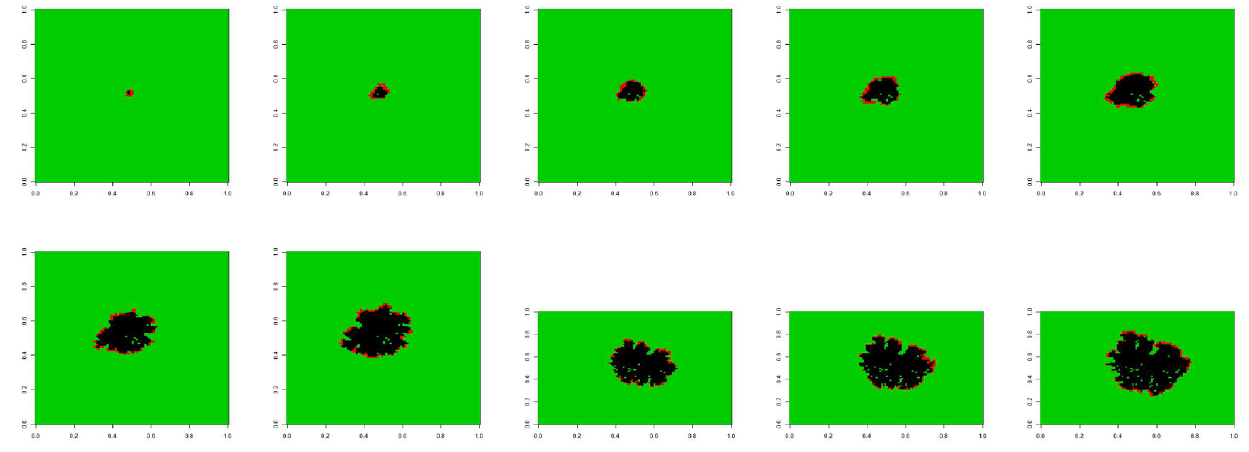
Figure 2. Thresholded patterns for the third microfire. Unburned areas are coded as the light grey (green, if in colour), burning regions are at an intermediate grey shade (or red), and burnt regions are